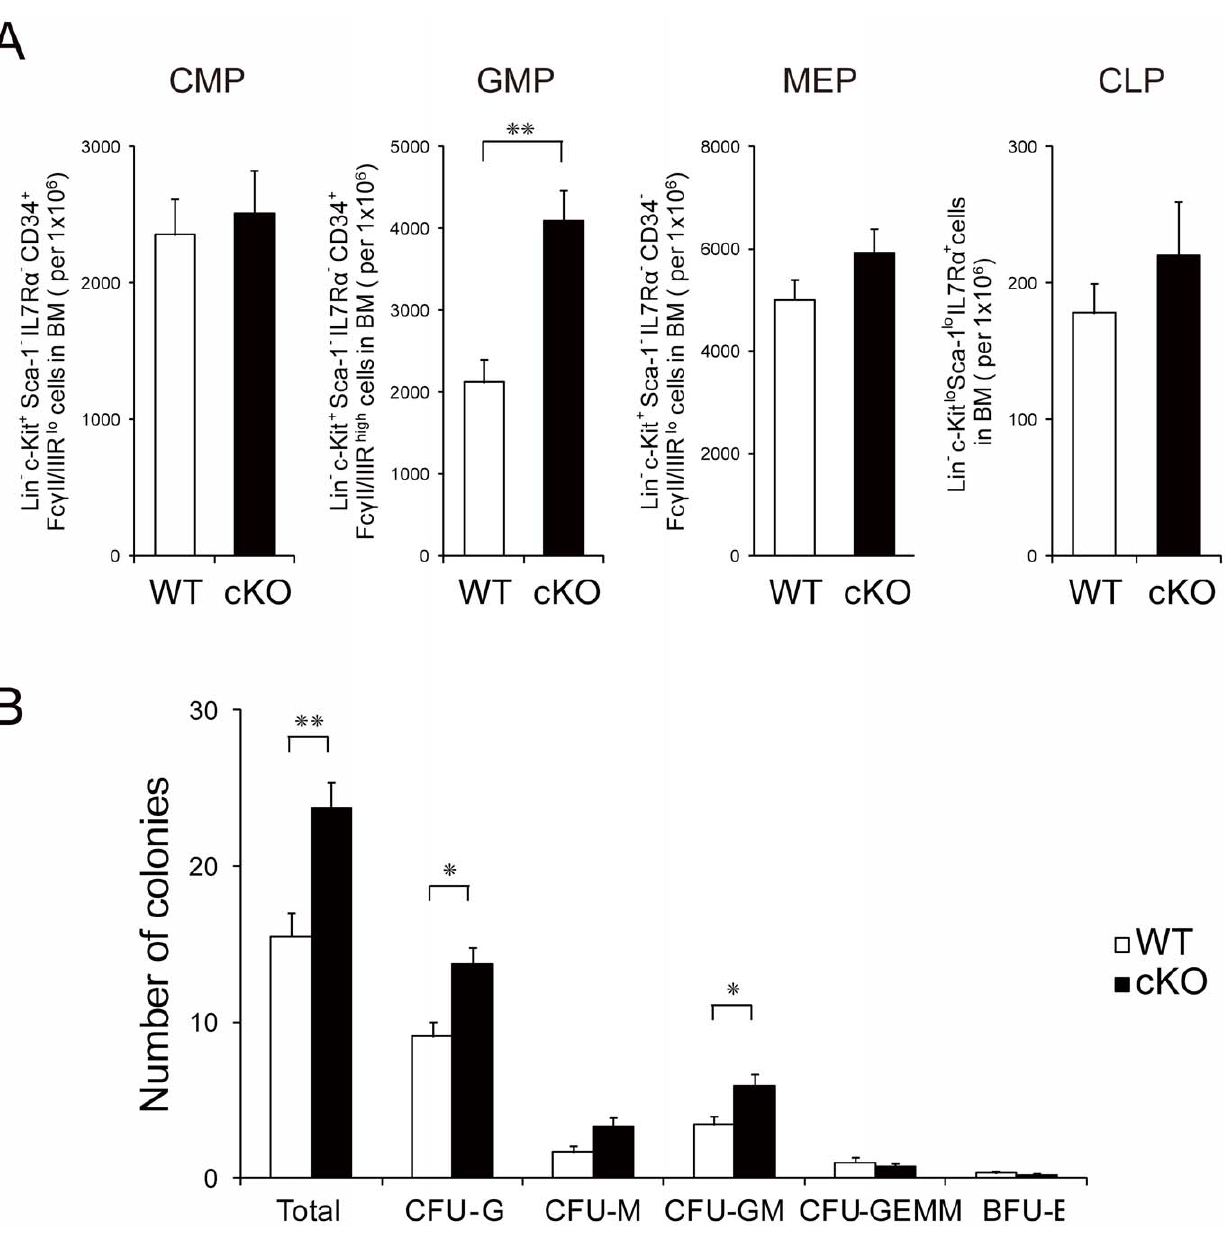
Figure 3. GRP94 deficiency led to increased granulocyte–monocyte progenitors in the bone marrow. A) Quantitation of flow cytometric analysis of myeloid and lymphoid progenitors including common myeloid progenitor (CMP), granulocyte-monocyte progenitor (GMP), megakaryocyte-erythroid progenitor (MEP) and common lymphoid progenitor (CLP) from WT (n $ 7) and cKO (n $ 10) mice. B) Quantitation of colonies formed from unfractioned BM from WT (n=4) and cKO (n=7) mice in methylcellulose medium. All data are presented as mean 6 s.e., *p , 0.05, **p , 0.01.